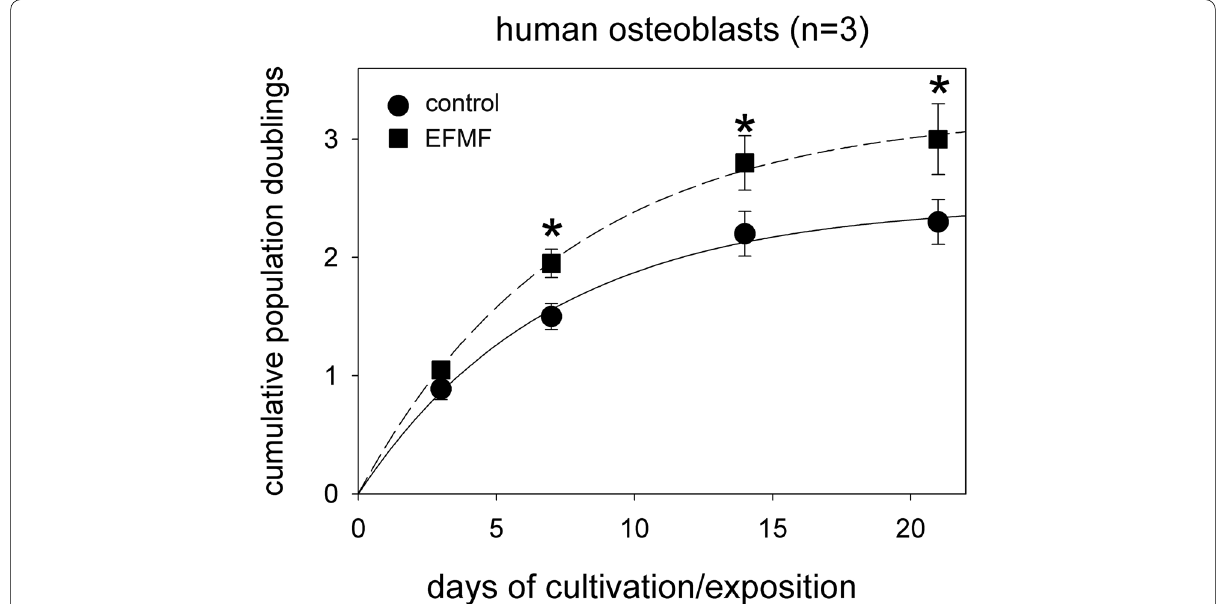
Fig. 2 Effect of EFMF exposure on cell proliferation of hOBs. Cumulative population doublings in EFMF-treated hOBs over 21 days of exposure. * p < 0.05 as compared to control cells. Data are derived from 3 independent